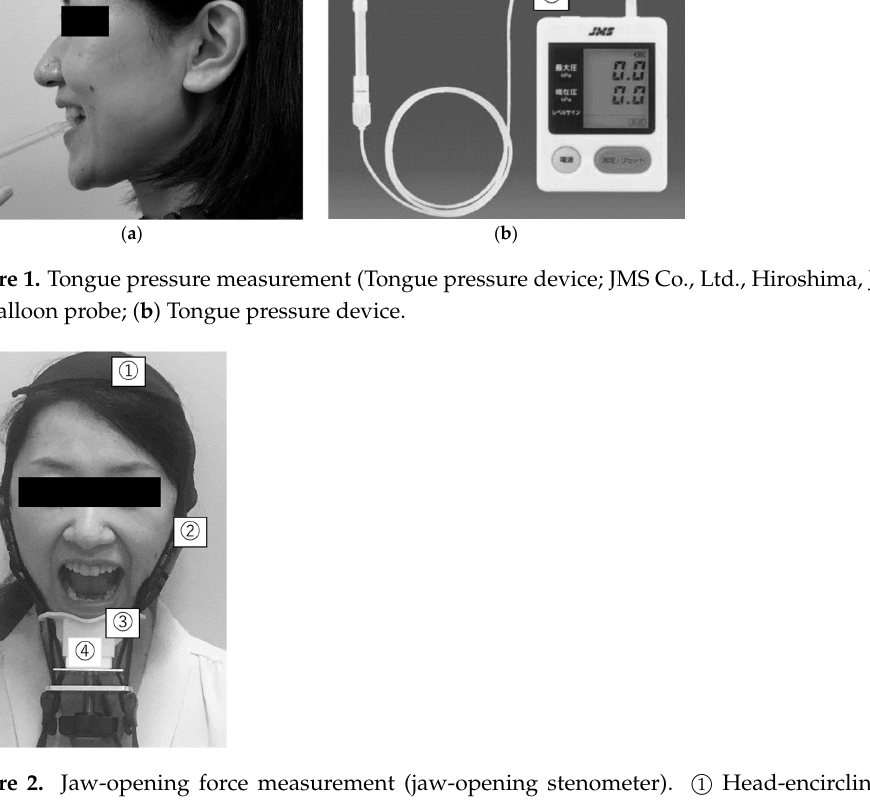
Figure 3. Ultrasonographic measurement. ① Position of the convex probe for the tongue; ② The cross-sectional area of the tongue in an ultrasonographic image; ③ Position of the convex probe for the geniohyoid muscle; ④ The cross-sectional area of the geniohyoid muscle in ultrasonographic images. 2.2. Participants A total of 122 independent community-dwelling participants aged ≥ 65 years were recruited for this cross-sectional study in October 2018 in Oyama, Tochigi, Japan. Recruit- ment was announced by the Oyama City Hall and the Oyama City Dental Association (Tochigi, Japan). The final analysis was based on 88 community-dwelling participants (30 men, 58 women; mean age, 71.0 ± 5.4 years). The inclusion criteria were as follows: (i) age >65 years; (ii) ability to follow instructions for measurements of jaw-opening, HGS, and gait speed; and (iii) provision of informed consent to participate in this study. The exclu- sion criteria for this study were as follows: (i) poorly controlled disease symptoms, (ii) a